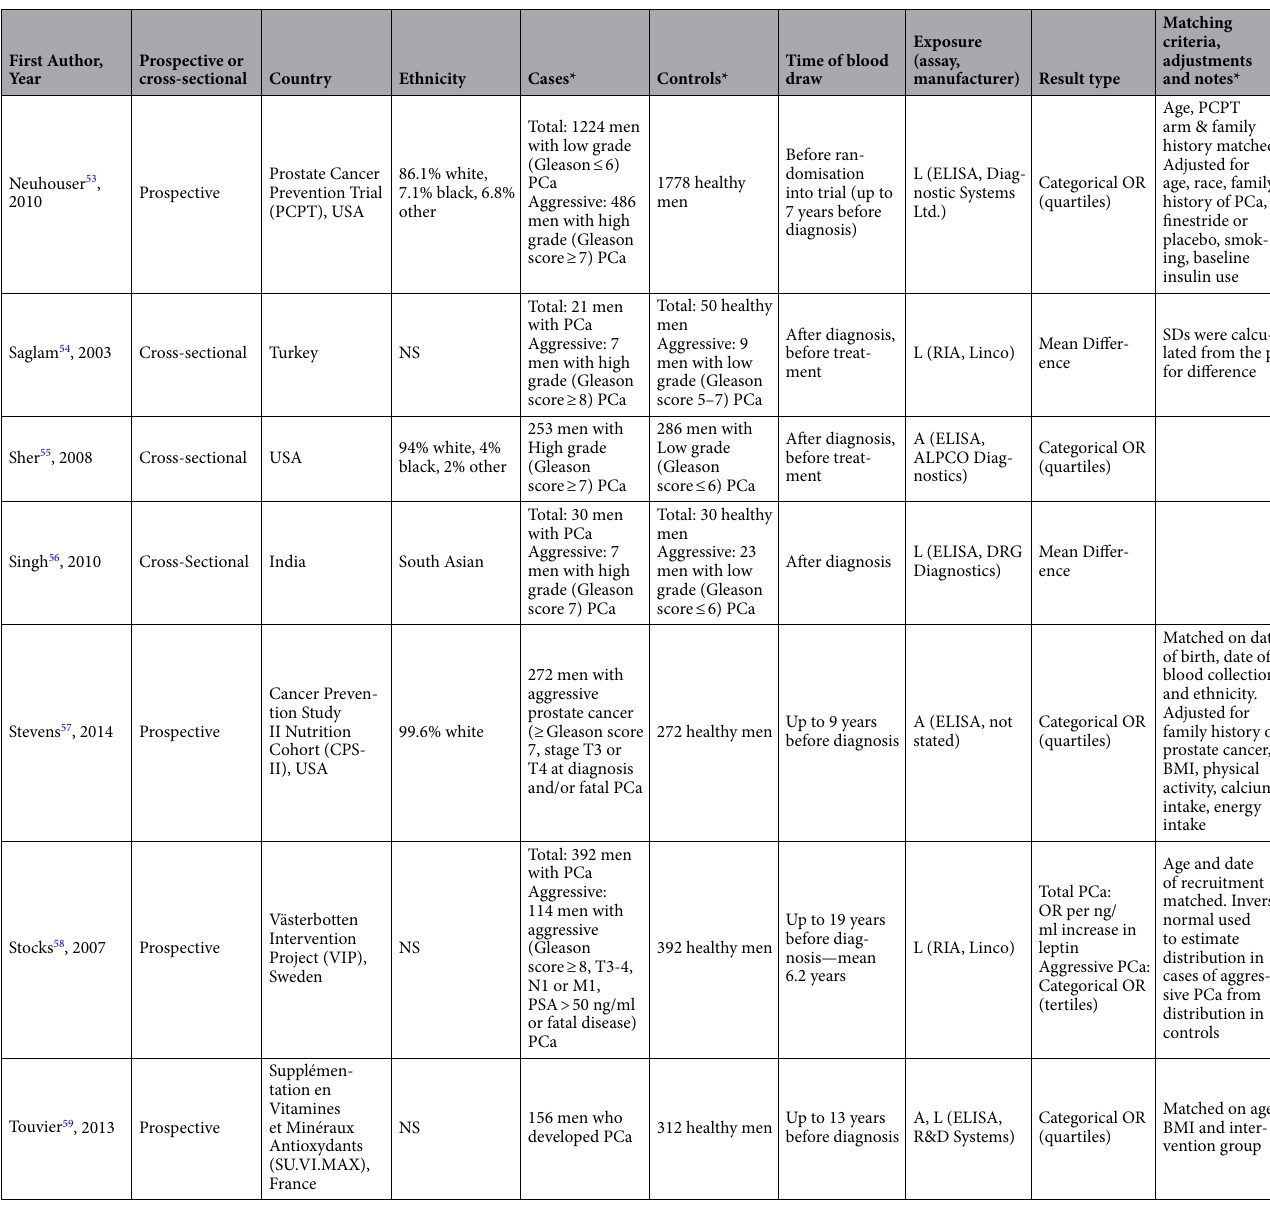
Table 1. Study characteristics. * For estimate used in the main analyses. PCa prostate cancer; ELISA enzyme- linked immunoassay; RIA radioimmunoassay; MAP multi-analyte profiling; LTIA latex